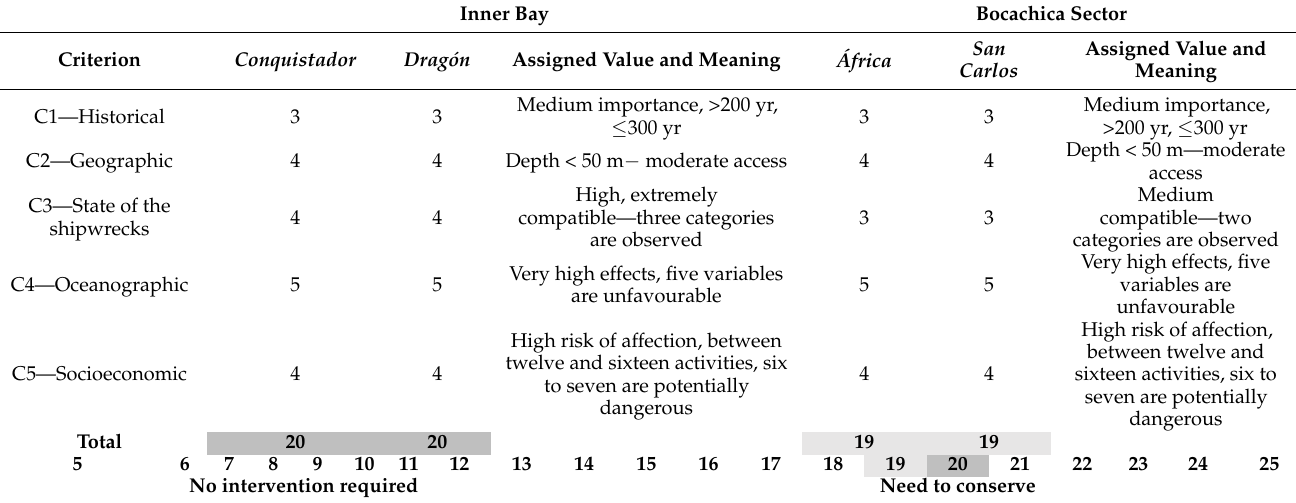
Table 4. Values of considered criterion for the Cartagena Bay study cases.